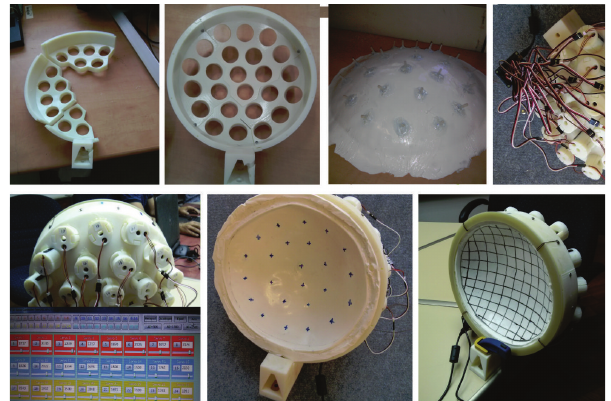
Figure3:Theearlyprintedmodelofthedynamicsubreflector.Itwas mostly printed using a 3D-printer. Each position accommodated a round shape housing which simplified the assembly process.